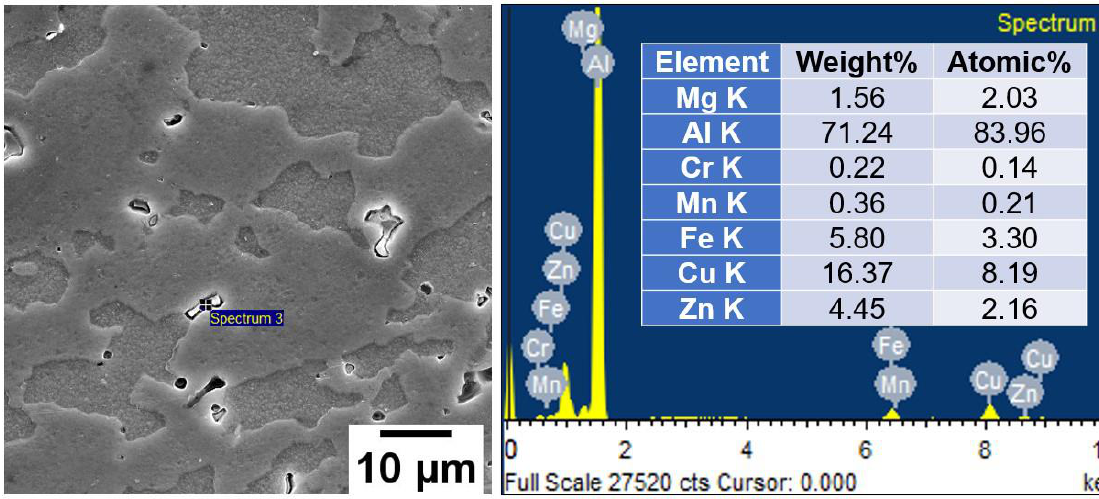
Figure 4. SEM image and EDS analysis of the AA7075-ST (Base).